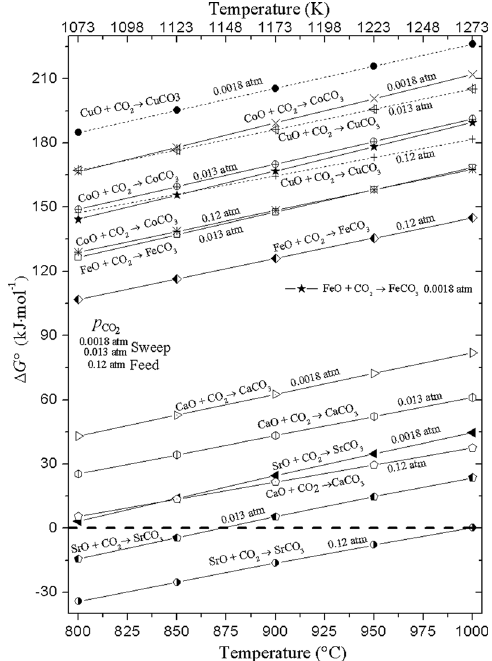
Fig. 12 Gibbs energy change for carbonation reactions. The partial pressure in atm corresponds to the P CO2 for the feed and sweep